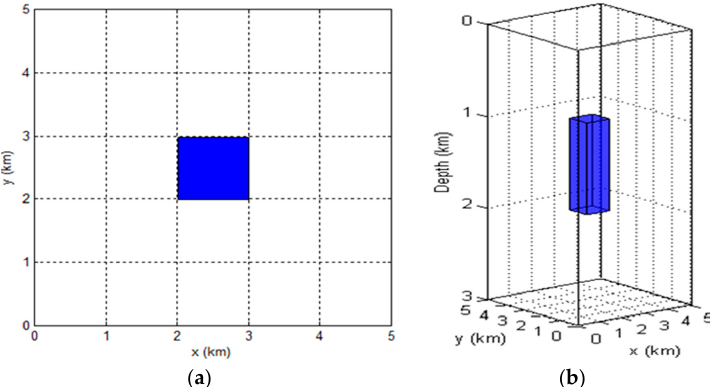
Figure 4. The perspective view of prisms model with size 1 km 3 at 1 km depth with 0.43 g/cm 3 of the density contrast ( a ) a plan view; ( b ) 3D view.